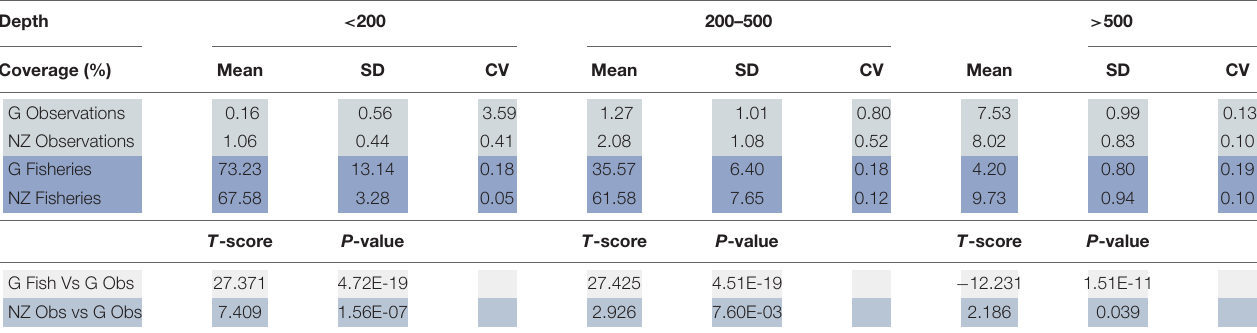
FIGURE 4 | Comparison of mean monthly observation and fishing coverage, divided by depth category, between New Zealand local data sources (top) and the global data sources used in subsequent analyses (bottom) . Existing observations (light blue) and Fisheries (dark blue) indicate the percentage of the ocean area within a depth class where data were collected or fishing activity occurred. Standard deviation error bars quantify temporal variability of coverage between months. Note: the secondary for fisheries percent coverage is 10 × that for current observations. TABLE 1 | Summary statistics comparing observation and fisheries coverage in the New Zealand focus region. Standard deviations (SD) correspond to ( Figure 4 ) error bars, and CV is coefficient of variation. Raw, monthly New Zealand fisheries data were not available for T -test comparisons, with mean and SD calculated prior to the data